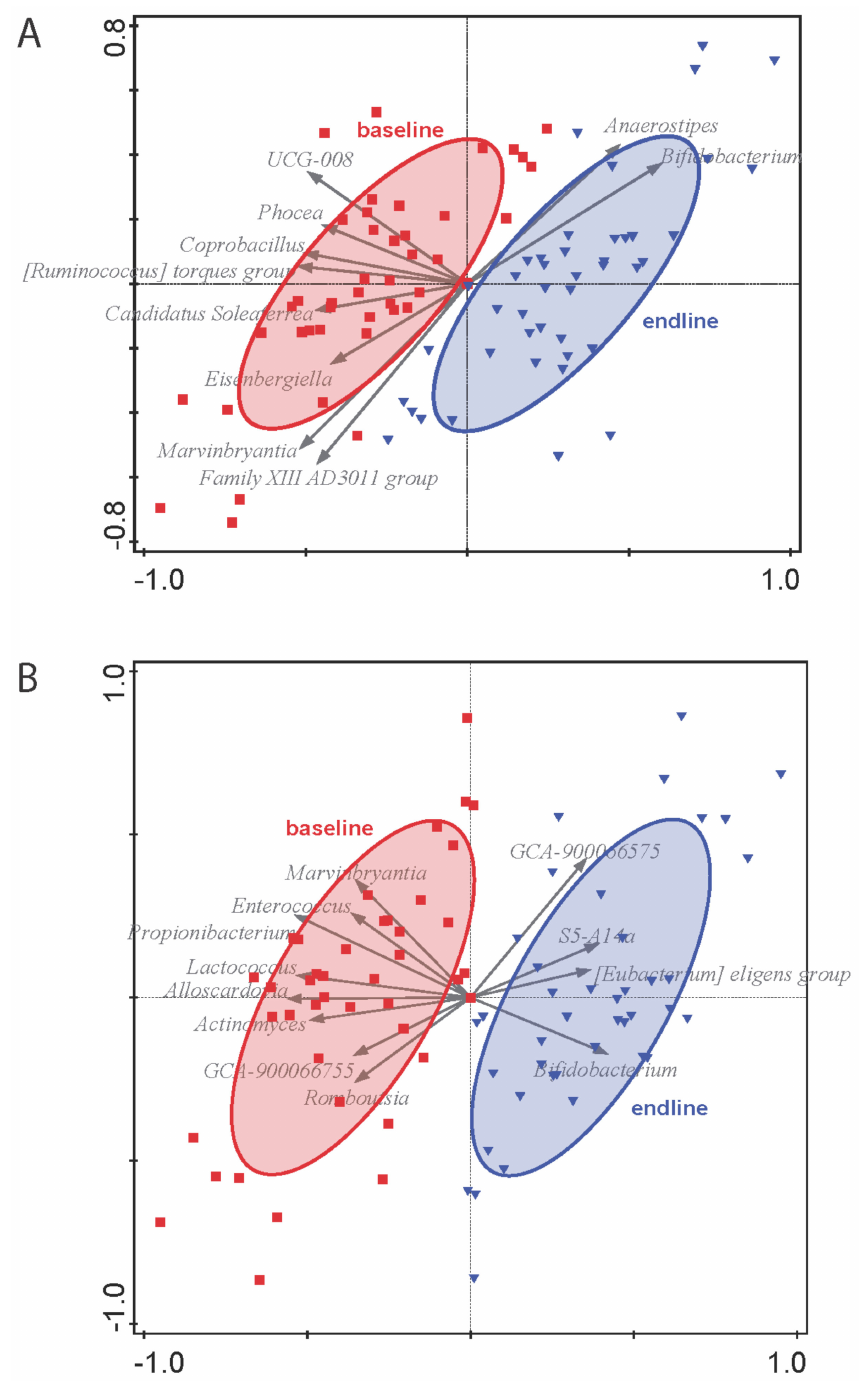
Figure 4. Partial RDA of ( A ) 11 g GOS group in time and ( B ) 5.5 g GOS group in time. Red squares represent baseline samples, blue triangles represent endline samples. Envelopes are 2D-normal-based ellipses at the 66% level. Grey arrows represent the genera with the best fit in the ordination space on the horizontal